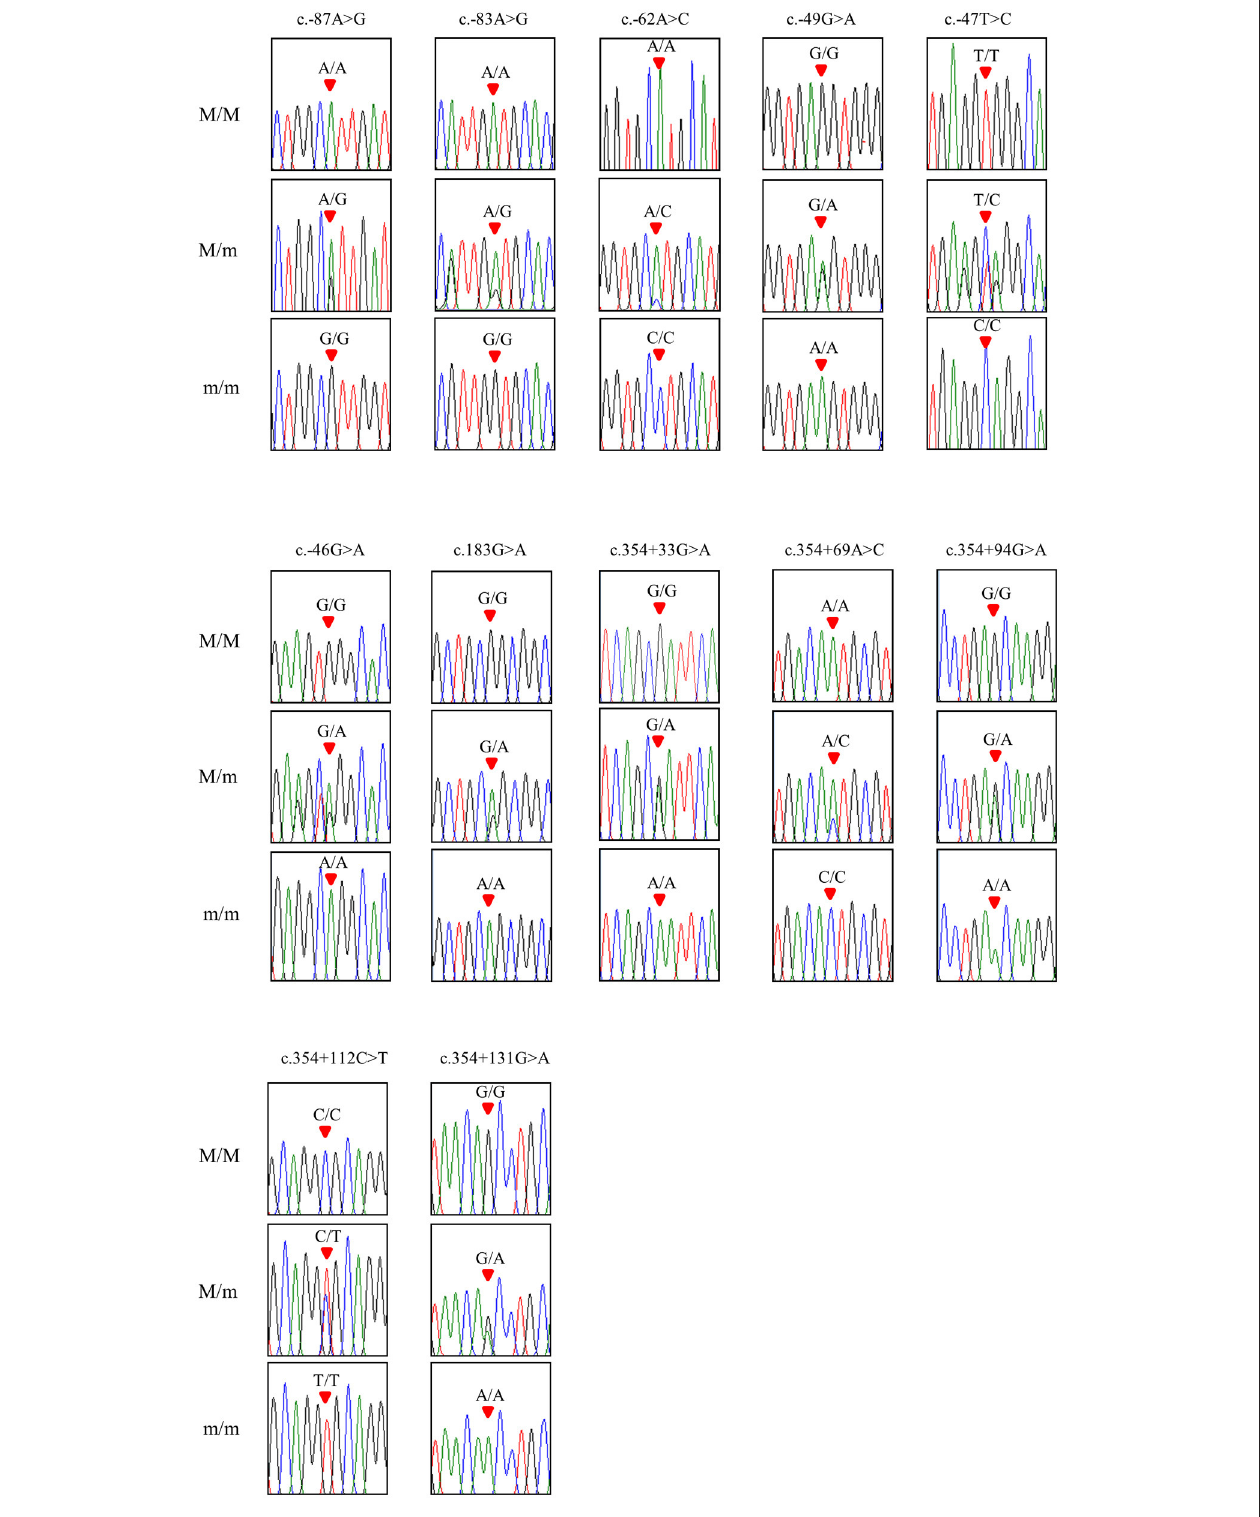
FIGURE 1 | Electropherograms of 12 novel single-nucleotide polymorphisms (SNPs) of the shadow of prion protein gene ( SPRN ) found in chickens. The colors of the peaks indicate each base of the DNA sequence (green: adenine; red: thymine; blue: cytosine; black: guanine). The red arrows indicate the location of SNPs found in the present study. M/M, M/m and m/m indicate major homozygotes, heterozygotes and minor homozygotes, respectively.